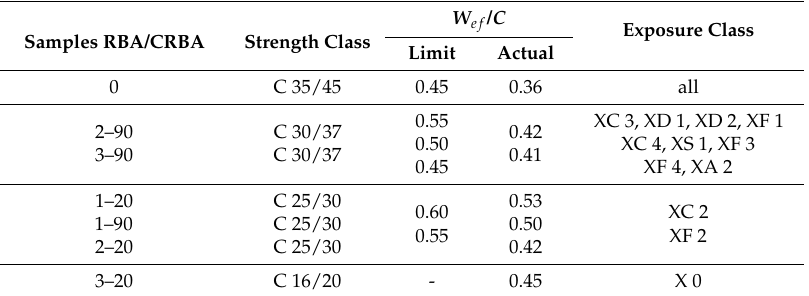
* STDEV: Standard deviation. Table 5. Exposure classes for individual samples in order of decreasing strength.